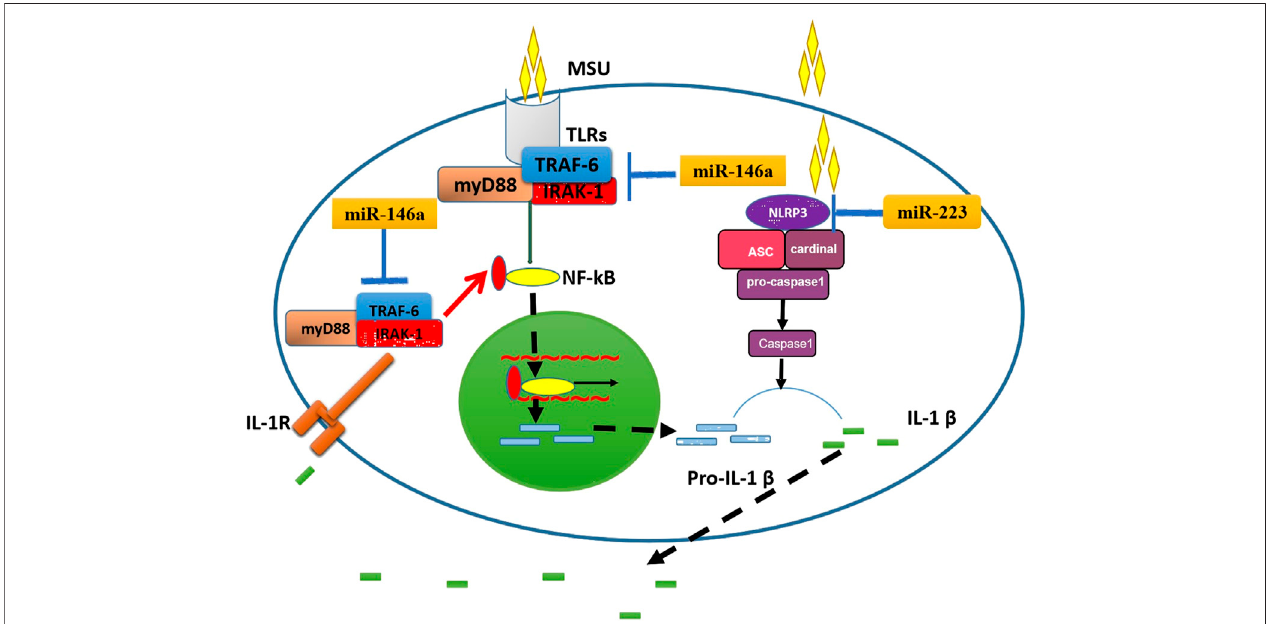
FIGURE6 | The potential mechanisms by which miR-146a and miR-223 in fl uence gouty arthritis. On theleft, the schematic shows how miR-146a mightdecrease IL-1 β production by inhibition of TRAF6 and IRAK1 function. On the right, the schematic shows how miR-223 reduces IL-1 β production by inhibiting NLRP3 function. ASC,apoptosis-associatedspeck-likeprotein; IL-1 β ,interleukin-1 β ;IL-1R,IL-1Receptor;IRAK1,IL-1receptor-associatedkinase1;MSU, monosodiumurate;NLRP3, NACHT-LRR-PYD-containing protein; Pro-IL-1 β , precursor of IL-1 β ; TLR, toll-like receptor; TRAF6, TNF receptor-associated factor